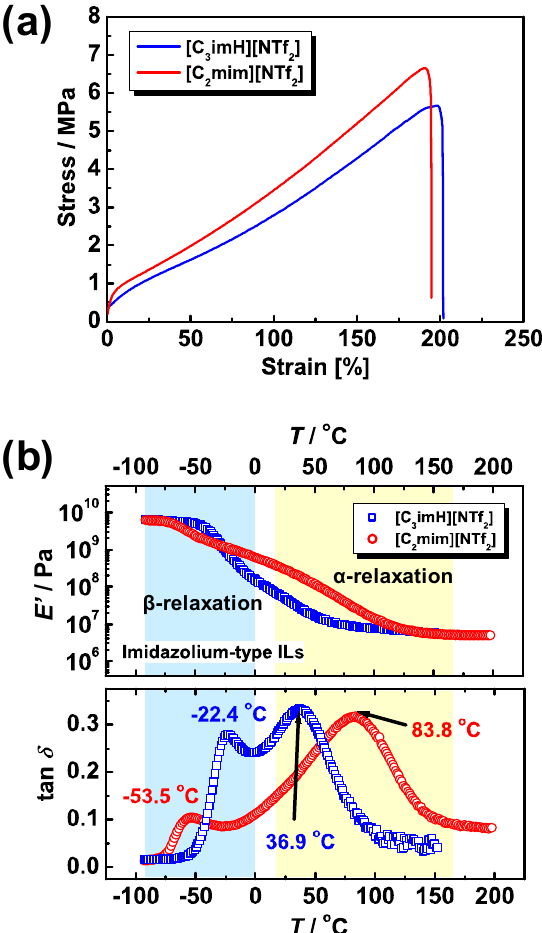
Figure 6. ( a ) Stress–strain curve and ( b ) results of dynamic mechanical analysis (DMA) analysis for PIL/SPI and AIL/SPI membranes containing 75 wt% of IL.